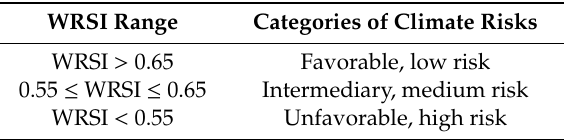
Table 3. Criteria for the definition of agroclimatic risk for soybean crops, according to water deficit